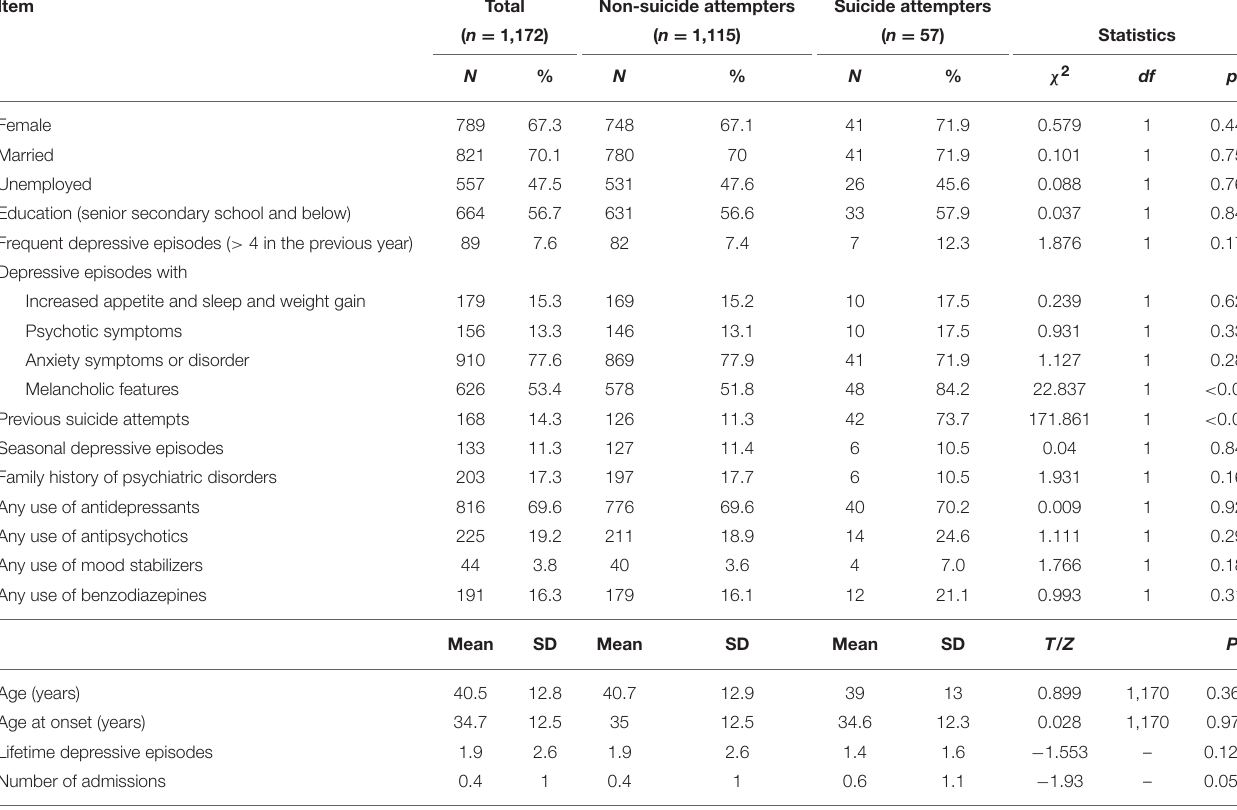
TABLE 1 | Comparison of the basic demographic and clinical variables between recent suicide attempters and non-recent suicide attempters diagnosed with MDD.